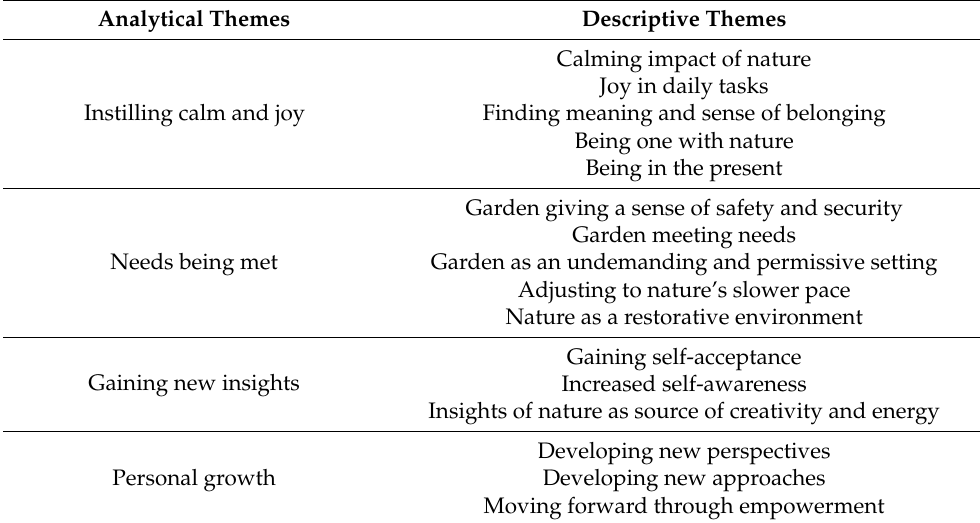
Table 4. Analytical and descriptive themes from the qualitative